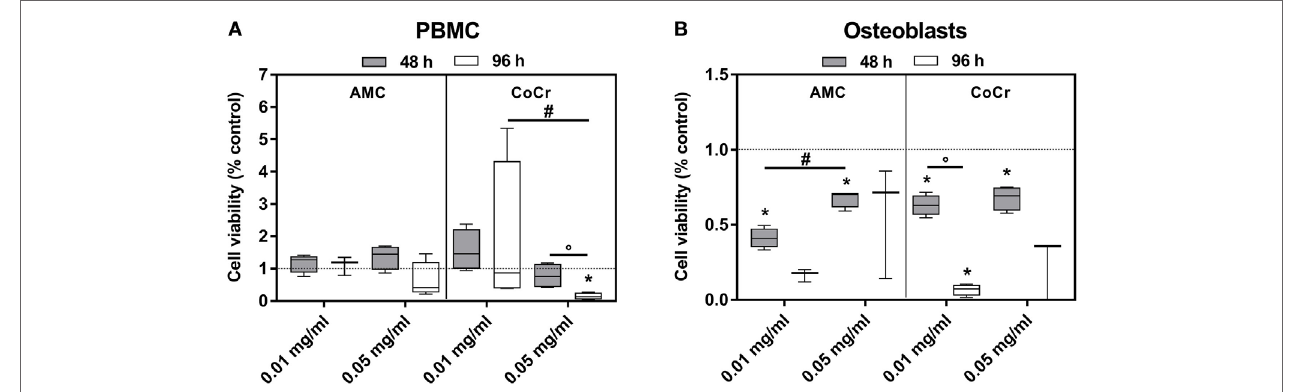
FigUre 3 | Cell viability of human PBMCs (a) and osteoblasts (B) after exposure to AMC and CoCr particles. Cells treated with the respective particle were analyzed using the WST-1 assay. Data are shown as box plots ( n ≥ 3). Significances between groups were calculated with the Mann–Whitney U -test (* p < 0.05, treated vs. untreated; # p < 0.05, 0.01 vs. 0.05 mg/ml; ° p < 0.05, 48 vs. 96